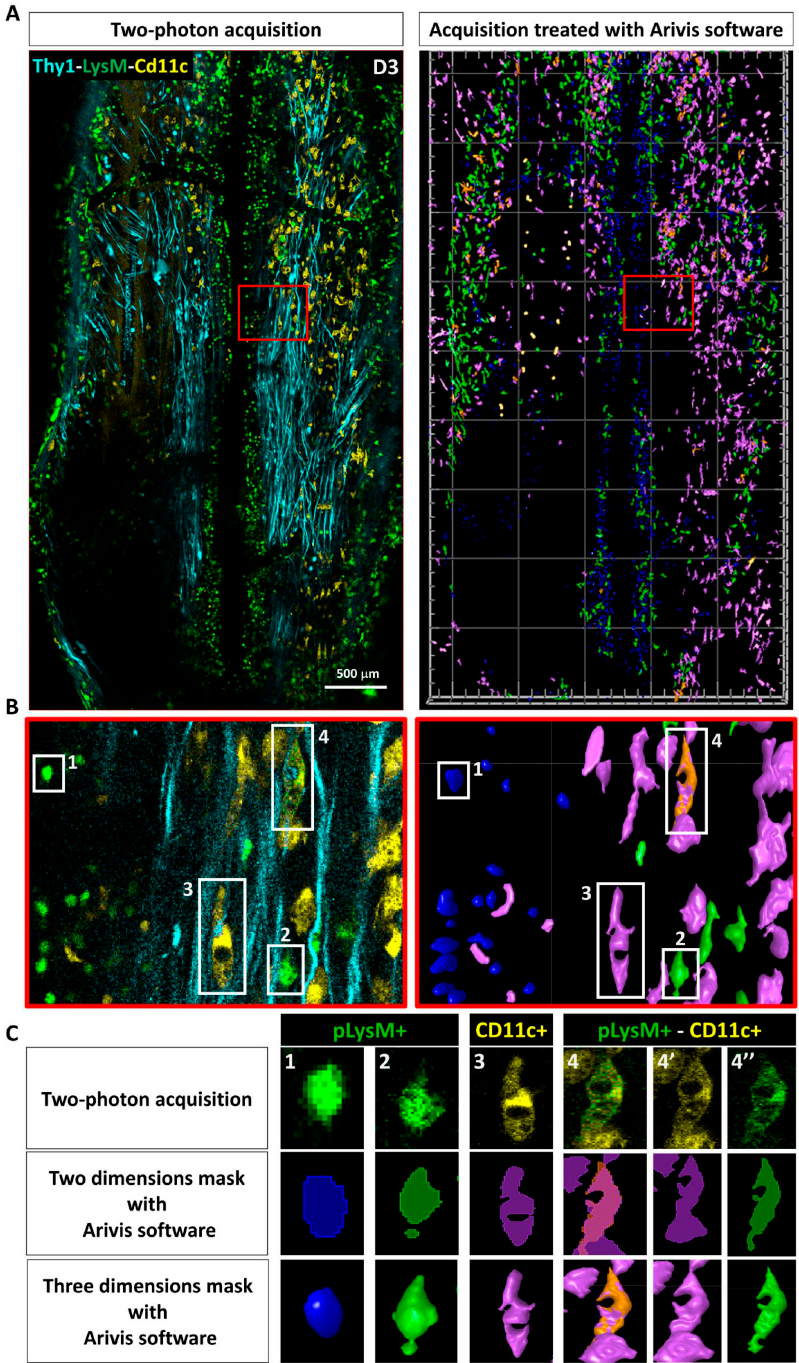
Figure 4. Automated image analysis pipeline used to characterize post-traumatic immune response. ( A ) Dorsal view obtained by intravital 2P microscopy 3 days after PUDQL in Thy1-CFP//LysM- EGFP//CD11c-EYFP triple transgenic mouse (left), and its corresponding 3D volume rendering following segmentation and labelisation of the cells using Arivis software (right). ( B ) Zoom in of the red squared area of ( A ) showing the four types of immune cells detected in the spinal axonal network. Raw data (left) and corresponding segmented images (right) ( C ) typical examples of each cell type presenting the raw 2P maximal intensity projection image, its 2D mask and 3D volume rendering obtained at the end of our Arivis analysis pipeline. 4-4’-4” show a double labelled pLysM+/CD11c+ cell in the multicolor image (4) as well as in each EYFP (4’) and EGFP (4”) channels that were analysed independently prior to making mask